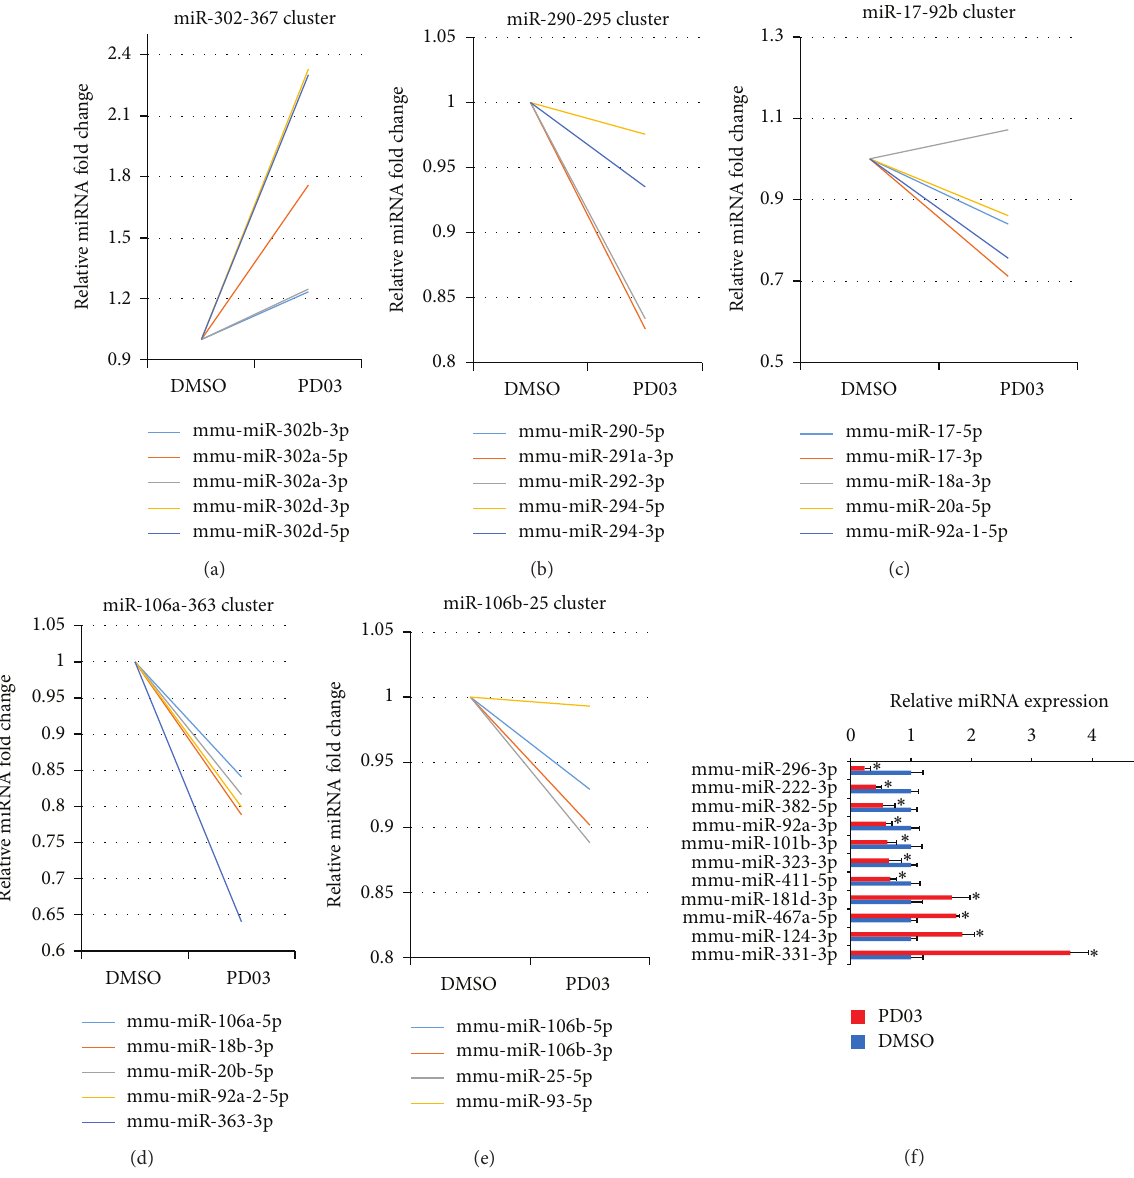
Figure 4: PD regulate the expression of the ESCC family of miRNAs in mESCs. (a–e) Relative fold change of mature ESCC family of miRNAs. J1 mESCs were treated with 1 𝜇 M PD or equal volume of DMSO (control) for 24 h, and then the total RNAs were extracted and qualified RNAs were analyzed by small RNA deep-sequencing to identify differentially expressed miRNA. miR-302-367 cluster, miR-290-295 cluster, miR-17- 92b cluster, miR-106a-363 cluster, and miR-106b-25 cluster in control and PD-treated J1 mESCs detected by small RNA deep-sequencing. (f) RT-qPCR validation of differentially expressed miRNA in PD-treated J1 mESCs. J1 mESCs were treated with 1 𝜇 M PD for 24 h, and then the expression of miRNAs was determined by RT-qPCR. Error bars indicate mean ± SD of three independent experiments, ∗ 𝑝 < 0.05 compared with